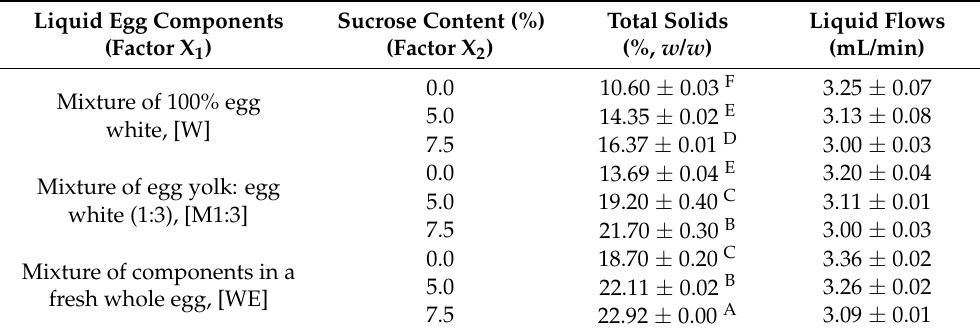
Table 1. Total solids and flows of mixtures prepared with fresh egg components and fed into the drying system (mean ± standard deviation, n =